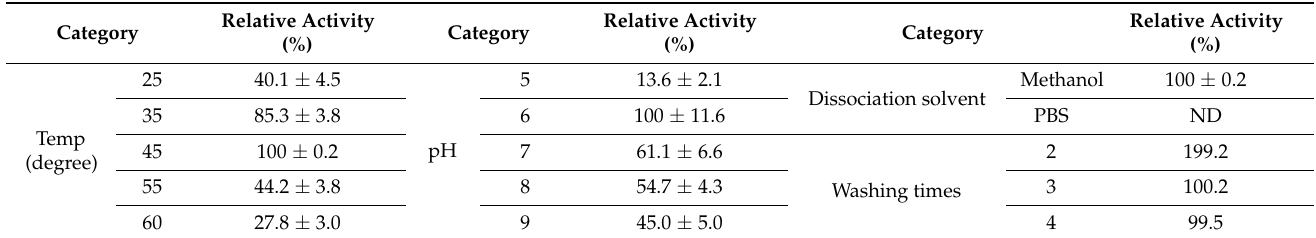
Table 1. Results of the experimental parameters during magnetic ligand fishing.